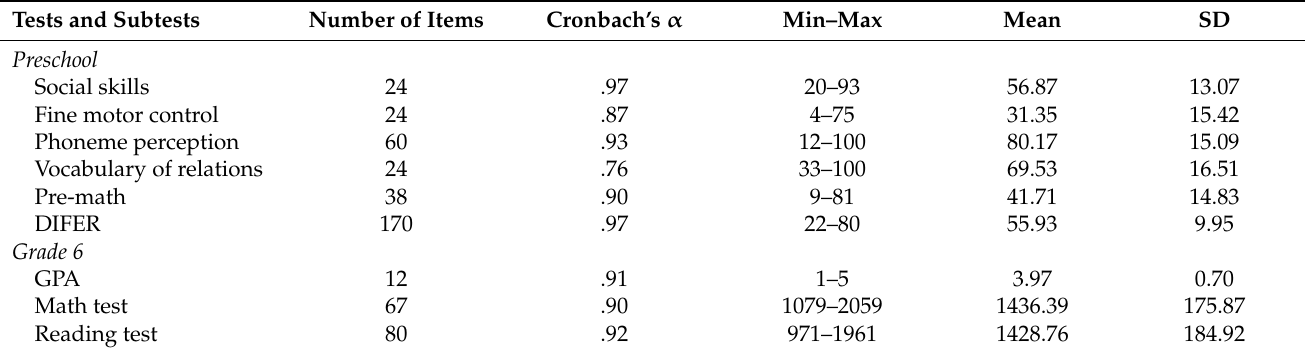
Table 1. Reliability and Descriptive